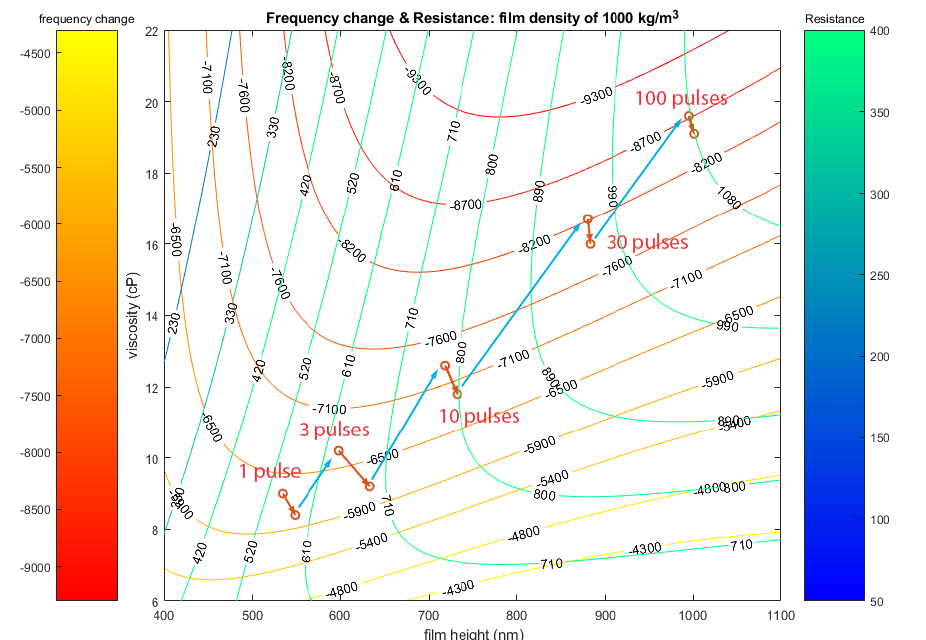
Figure 27. Combined contour plot of both resistance and frequency when glycerol film is exposed to water. The orange represents the frequency and resistance change of the coated QCM when exposed to water; the blue arrow indicates the direction of the frequency drift. Reprinted from [76] under the Creative Commons CC BY 4.0